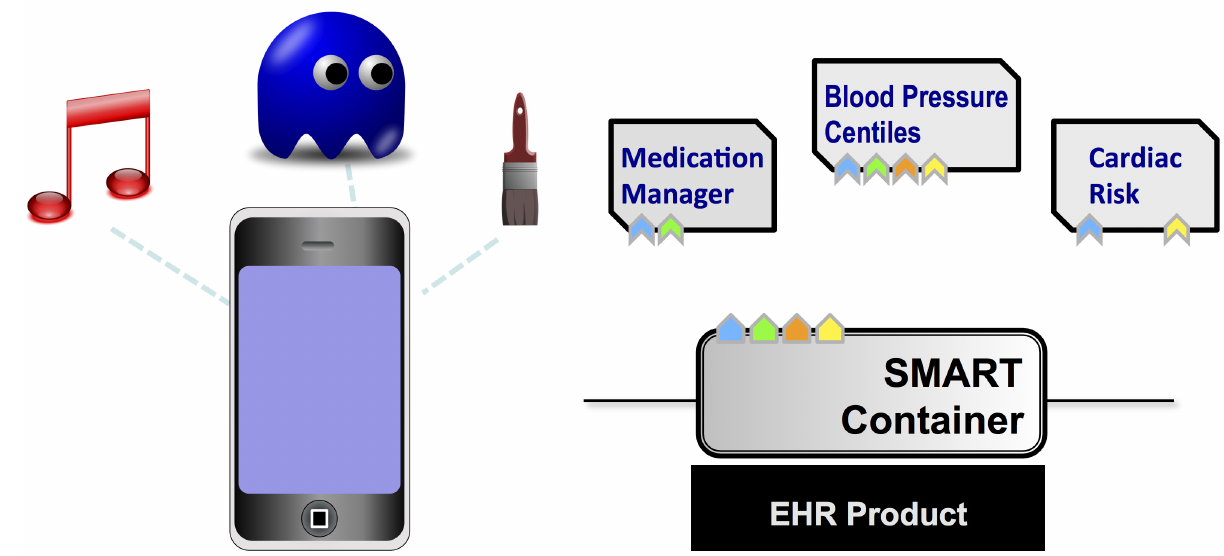
Figure 1. SMART enables an ecosystems of apps in medical systems, just as app stores enable this on smartphones. Portions adapted with permission from